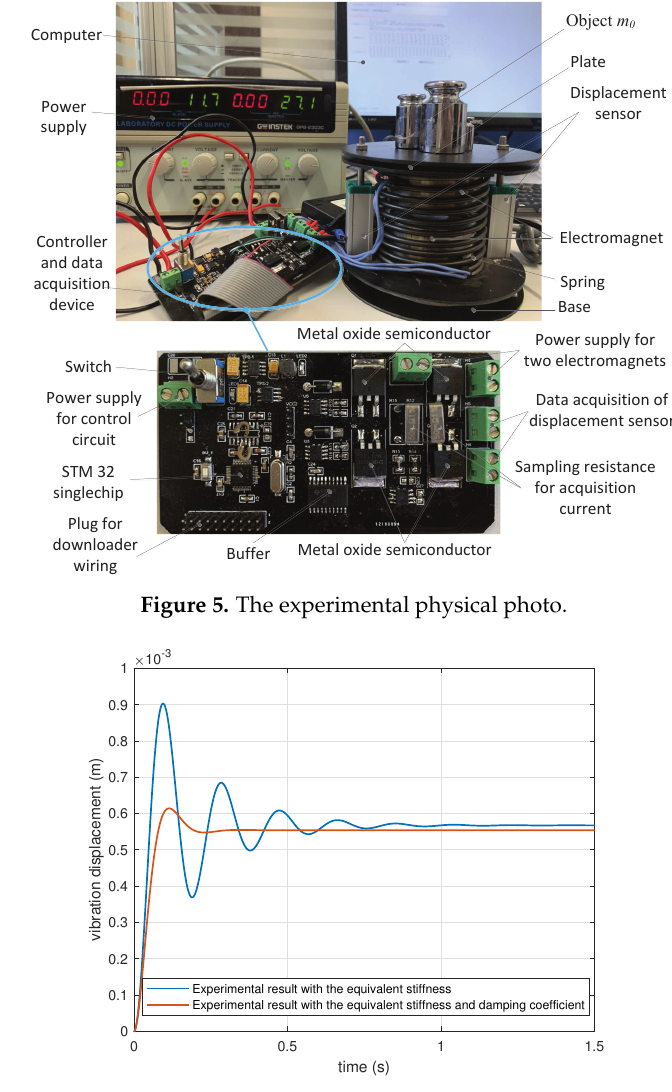
Figure 6. The experimental result with the active control